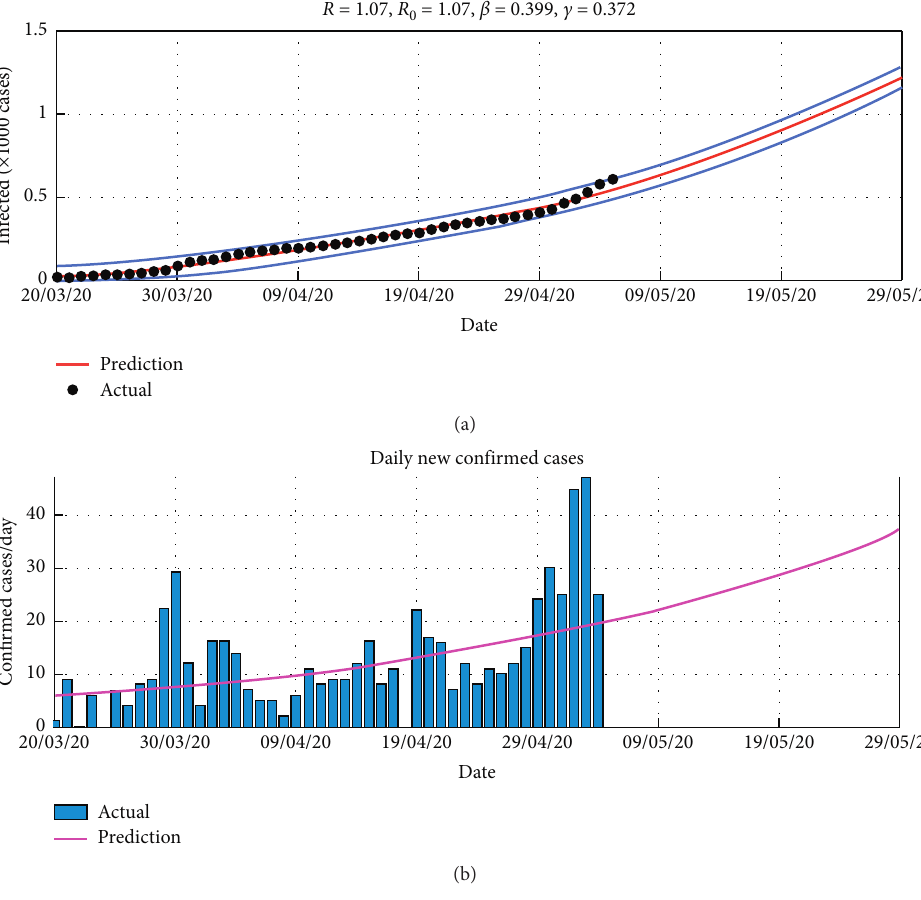
Figure 5: The basic reproduction number R is used to validate the results from the model. It shows that, in the period of simulations, the 0 models’ R in Figure 4 collates with the R of between 1.1 and 2 reported for the COVID-19 epidemic in 0 0